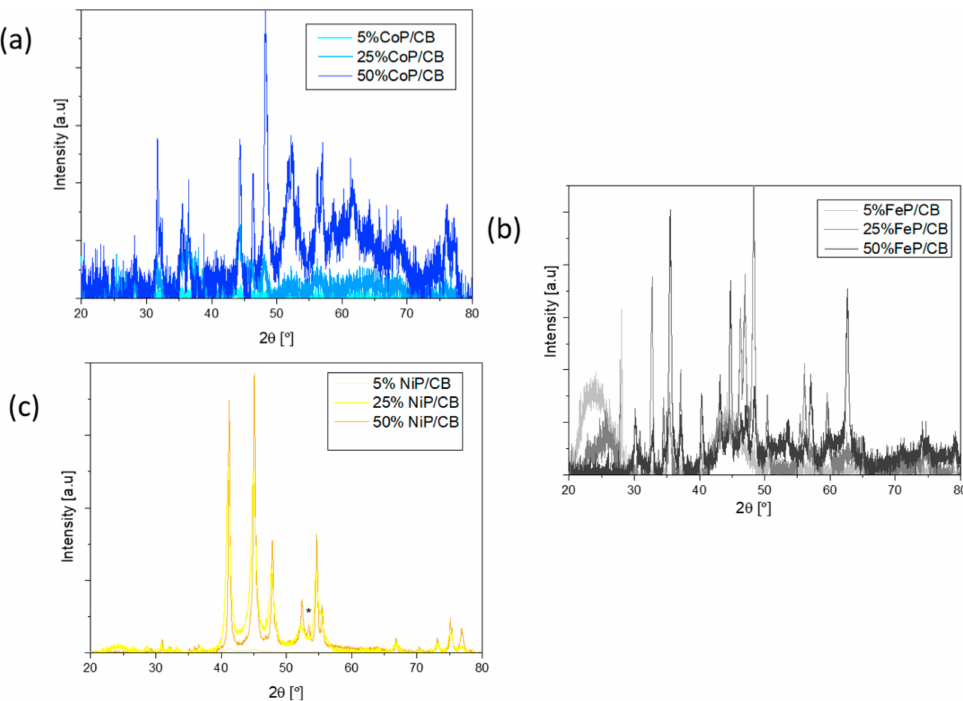
Figure 3. ( a ) XRD pattern of Co catalysts after the phosphorization process, ( b ) XRD pattern of Fe catalysts after the phosphorization process, ( c ) XRD pattern of Ni catalysts after the phosphorization